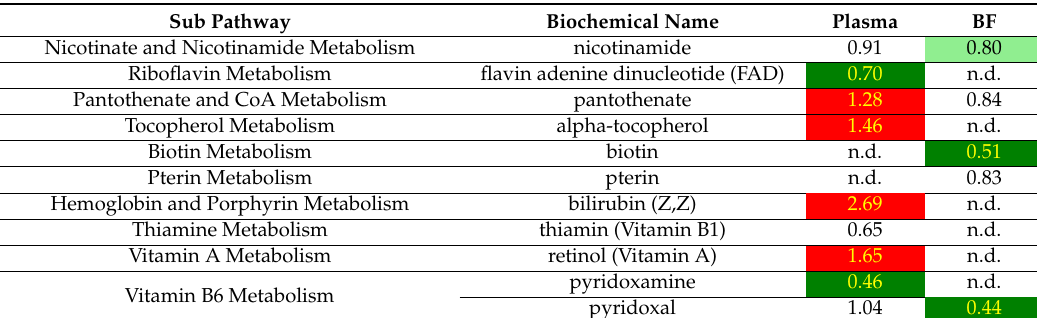
Table 6. List of selected cofactors and vitamins that were detected in maternal plasma and blastocysts cavity fluid (BF) in non-diabetic and diabetic